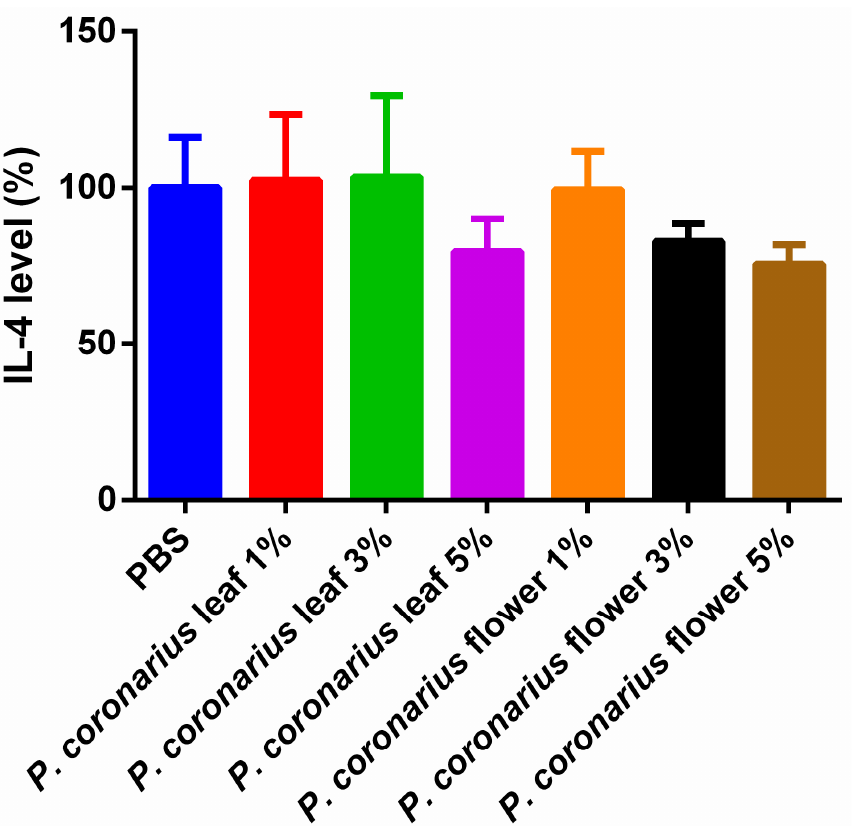
Figure 3. Results of IL-4 ELISA. Data represent the mean of six wells ± SD. Pretreating HaCaT cells with P. coronarius leaf (5%) and flower (3% and 5%) did not significantly reduce IL-4 production. Data are expressed as means ± SD; n = 5. To compare the groups, ordinary one-way ANOVA test was carried out.